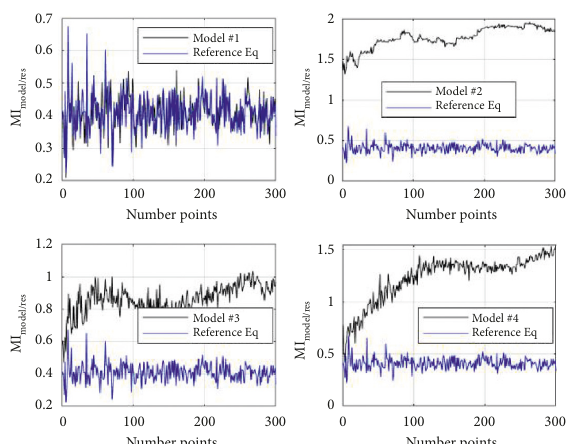
Figure 6: Plots of the mutual information between the models and the residuals for the models of Table 1 in Section 3.